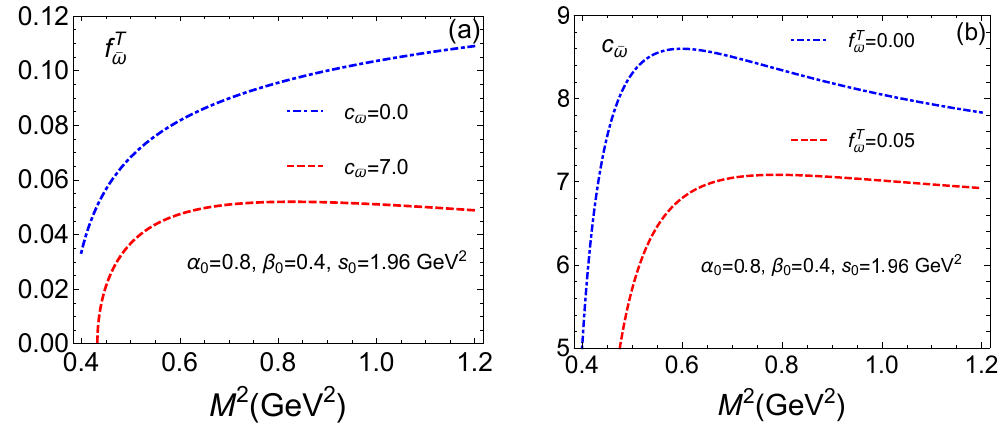
Figure 4 . Borel curve (a) for the meson pole residue f T ¯hy. coupling c ¯ ω